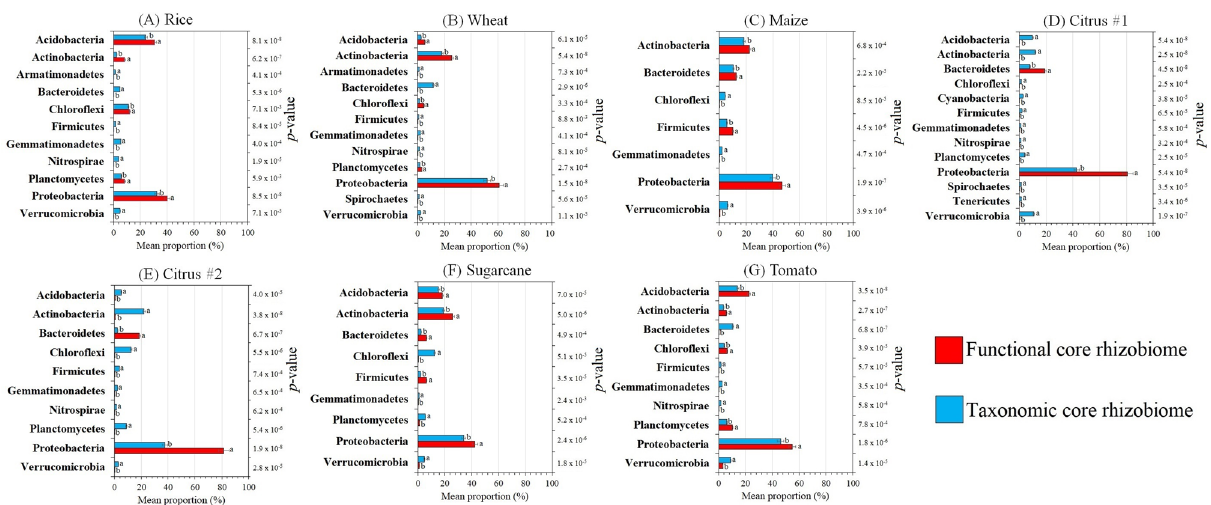
Figure 2. Histograms of phyla significantly different between taxonomic and functional core rhizobiomes according to the Welch’s t-test and Benjamini–Hochberg FDR multiple test correction for rice ( A ), wheat ( B ), maize ( C ), citrus #1 ( D ), citrus #2 ( E ), sugarcane ( F ), and tomato ( G ). The mean proportion (%) of the phyla in each taxonomic or functional core rhizobiome is shown. Letters above the bars indicate significant differences in the relative abundance of each phylum between taxonomic and functional core rhizobiomes, and p -values < 0.05 were considered significant. Bars marked with the same letter are not significantly The relative abundances of a subset of the genera identified in the core rhizobiomes were significantly different ( p < 0.05) between taxonomic and functional core rhizobiomes for rice (15 genera), wheat (14 genera), maize (12 genera), citrus #1 (25 genera), citrus #2 (36 genera), sugarcane (13 genera), and tomato (12 genera) (Fig. S3). For each rhizobiome study, a subset of specific genera was exclusively detected in one type of core rhizobiome (Supplementary Data 1): rice (40 genera), wheat (17 genera), maize (15 genera), citrus #1 (28 genera), citrus #2 (22 genera), sugarcane (15 genera), and tomato (17 genera).